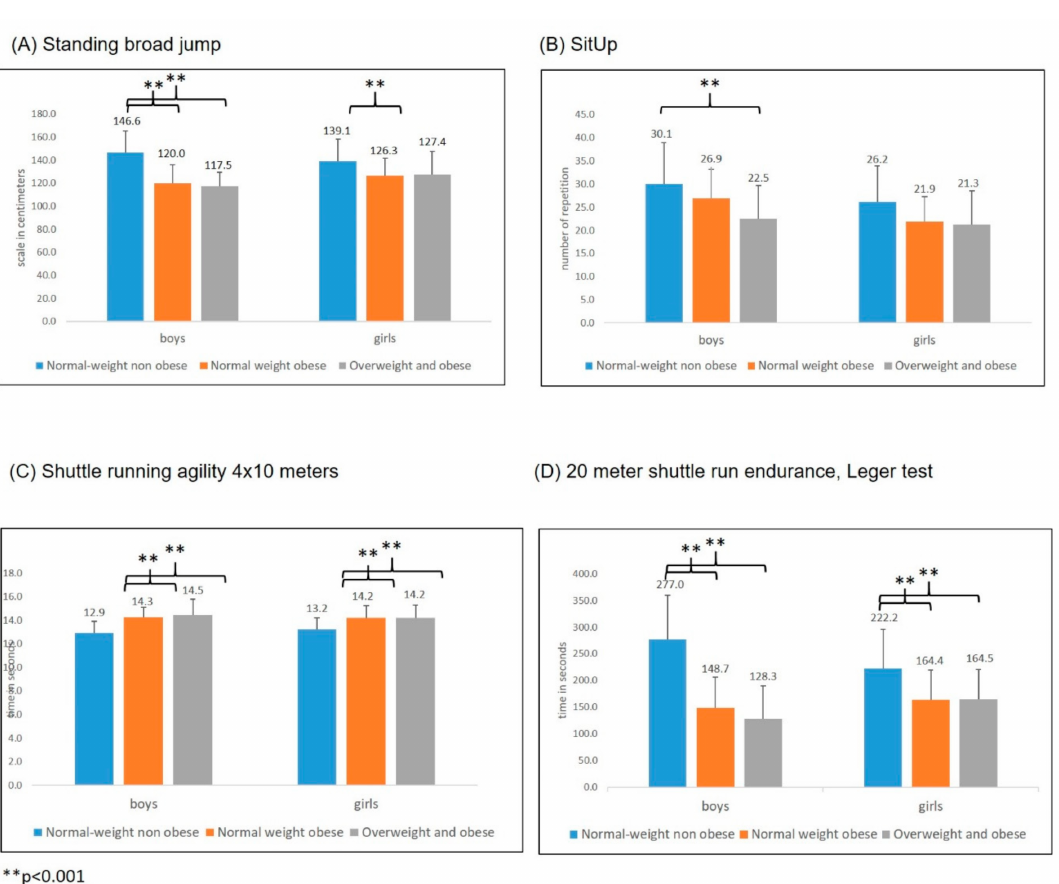
Figure 3. Di ff erences in lower limb explosivity, strength endurance of trunk muscles, running agility and endurace performances between Normal-weight non obese, Normal-weight obese and Overweight and obese groups considering